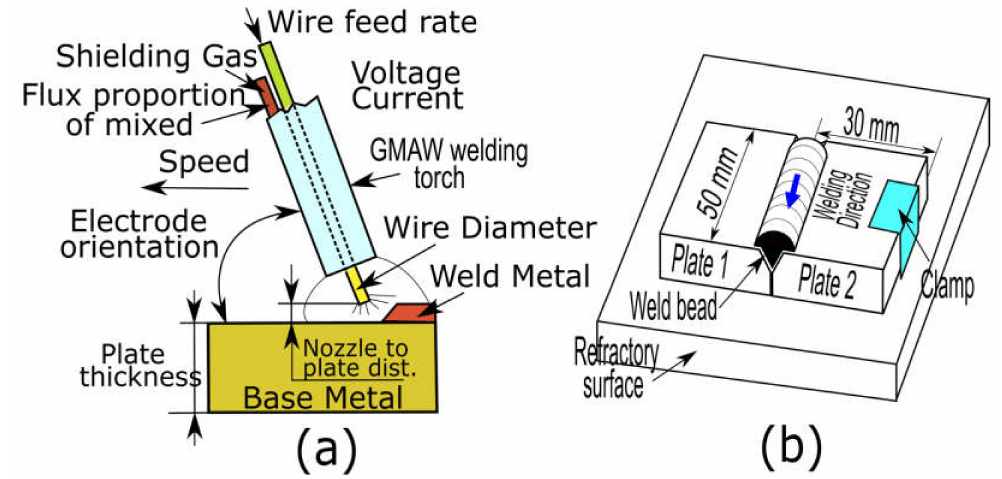
Figure 1. ( a ) Common welding parameters used in gas metal arc welding (GMAW); and, ( b ) The welding process used to manufacture the butt joint single